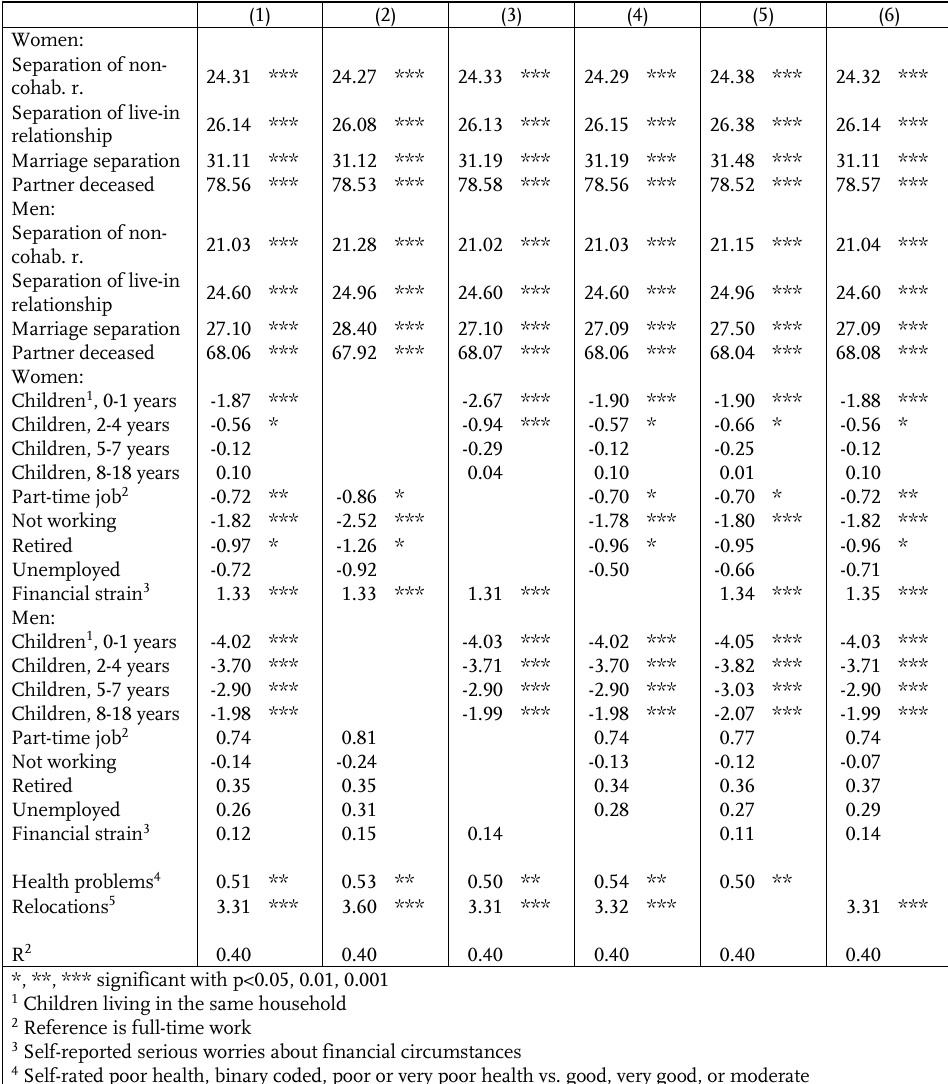
Table A.8 : Effects of relationship endings, children, employment, financial strain, relocations, and health on absence of primary-sphere contacts (having no partner and living alone; linear-probability models with fixed effects, percentage